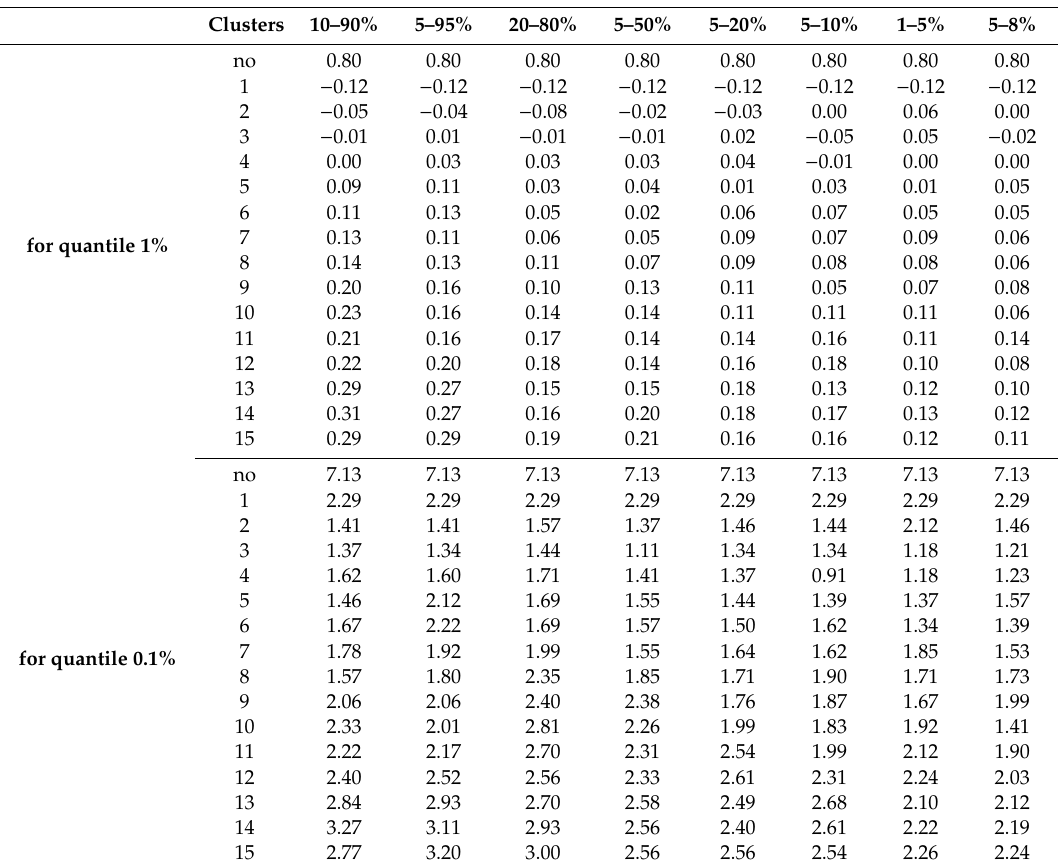
Table 1. Evolution of reliability for 0.1% and 1% levels of probability, depending on the number of clusters and couples of quantiles